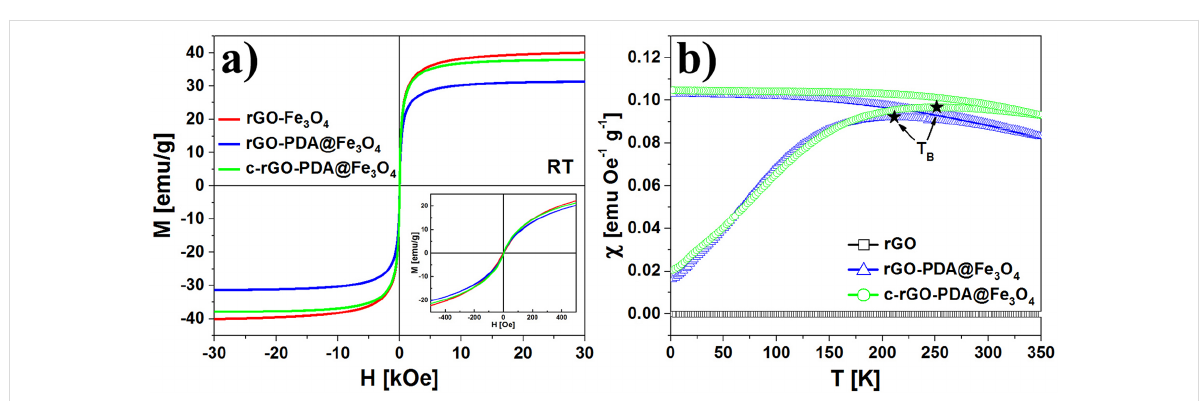
Figure 7: Room temperature M–H curves of rGO-Fe 3 O 4 , rGO-PDA@Fe 3 O 4 and c-rGO-PDA@Fe 3 O 4 aerogels (a). The inset in (a) presents M–H curves at low magnetic field. ZFC and FC temperature dependences of susceptibility for rGO, rGO-PDA@Fe 3 O 4 and c-rGO-PDA@Fe 3 O 4 aerogels under the applied field of 100 Oe are shown in